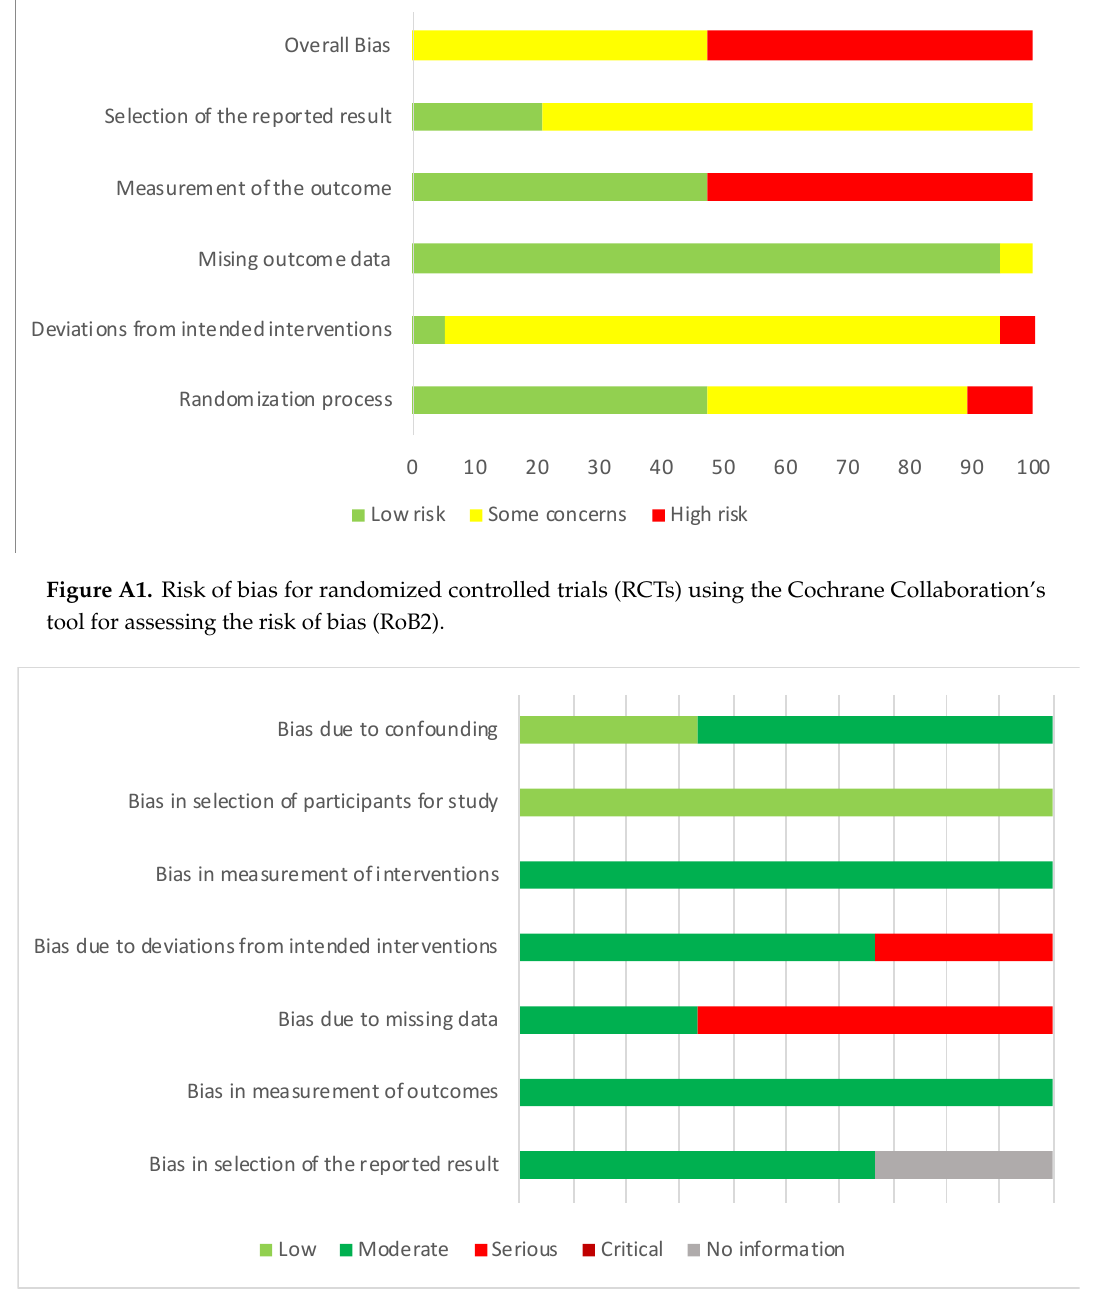
Figure A2. Risk of bias for non-RCTs using the ROBINS-I tool.